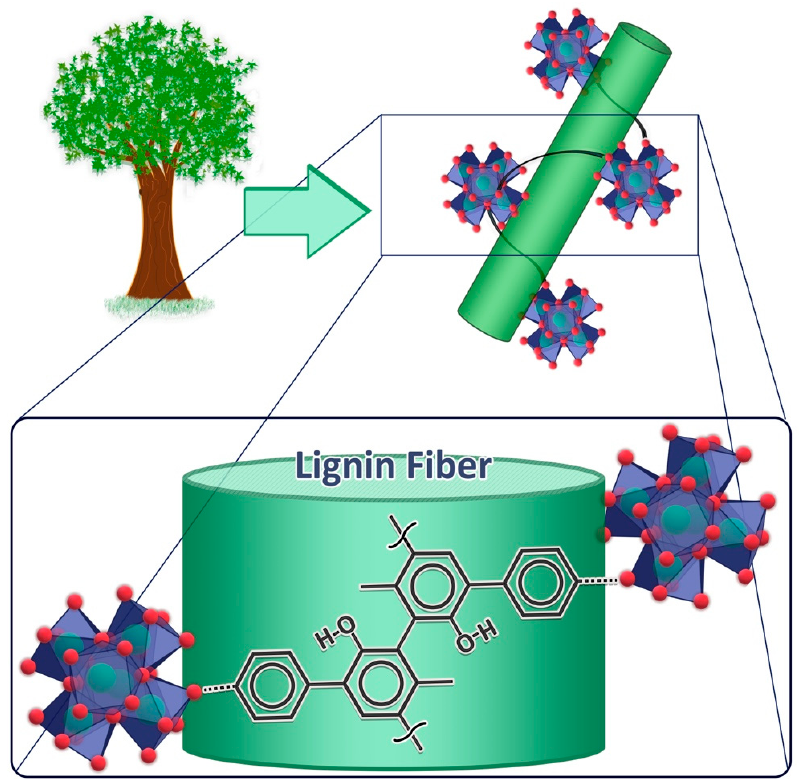
Figure 11. Metal organic framework (MOF)-lignin hybrid material inspired by linear coordinated MOFs synthesized by Jiang and collaborators [189] .